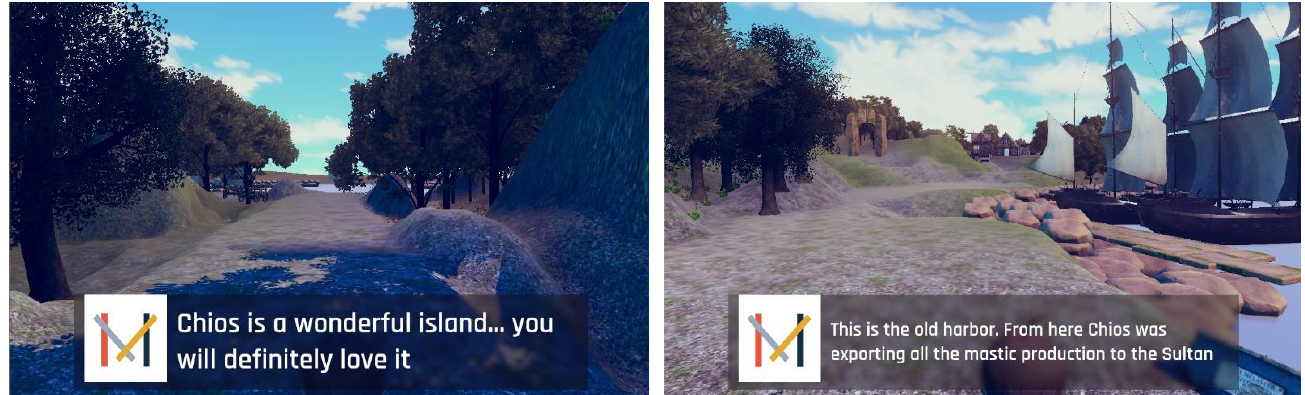
Figure 20. Setting transition points through teleports ( left ), mini video from the main game plot ( right ).